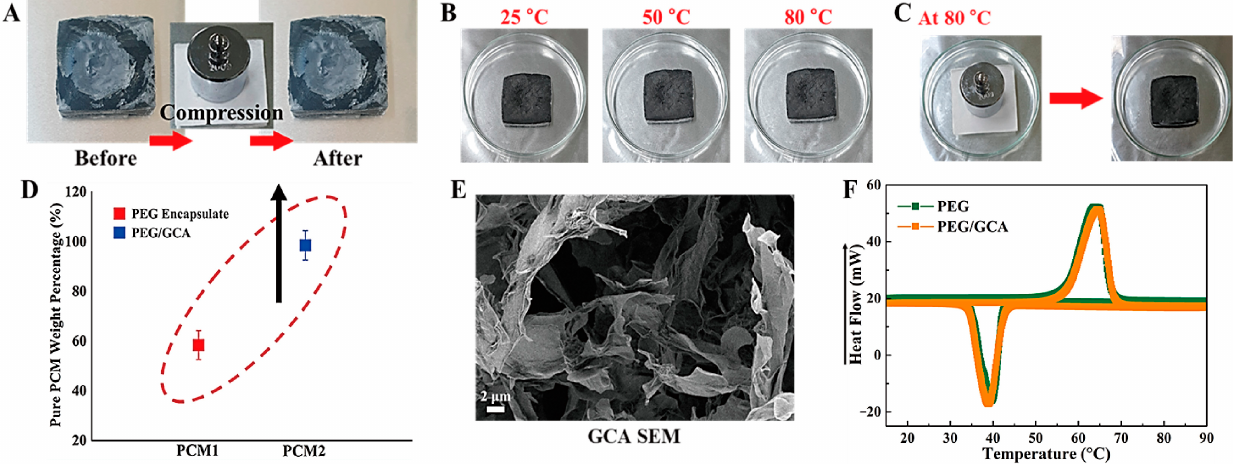
Figure 7. Schematic demonstration of the volume shrinkage of graphene aerogel.